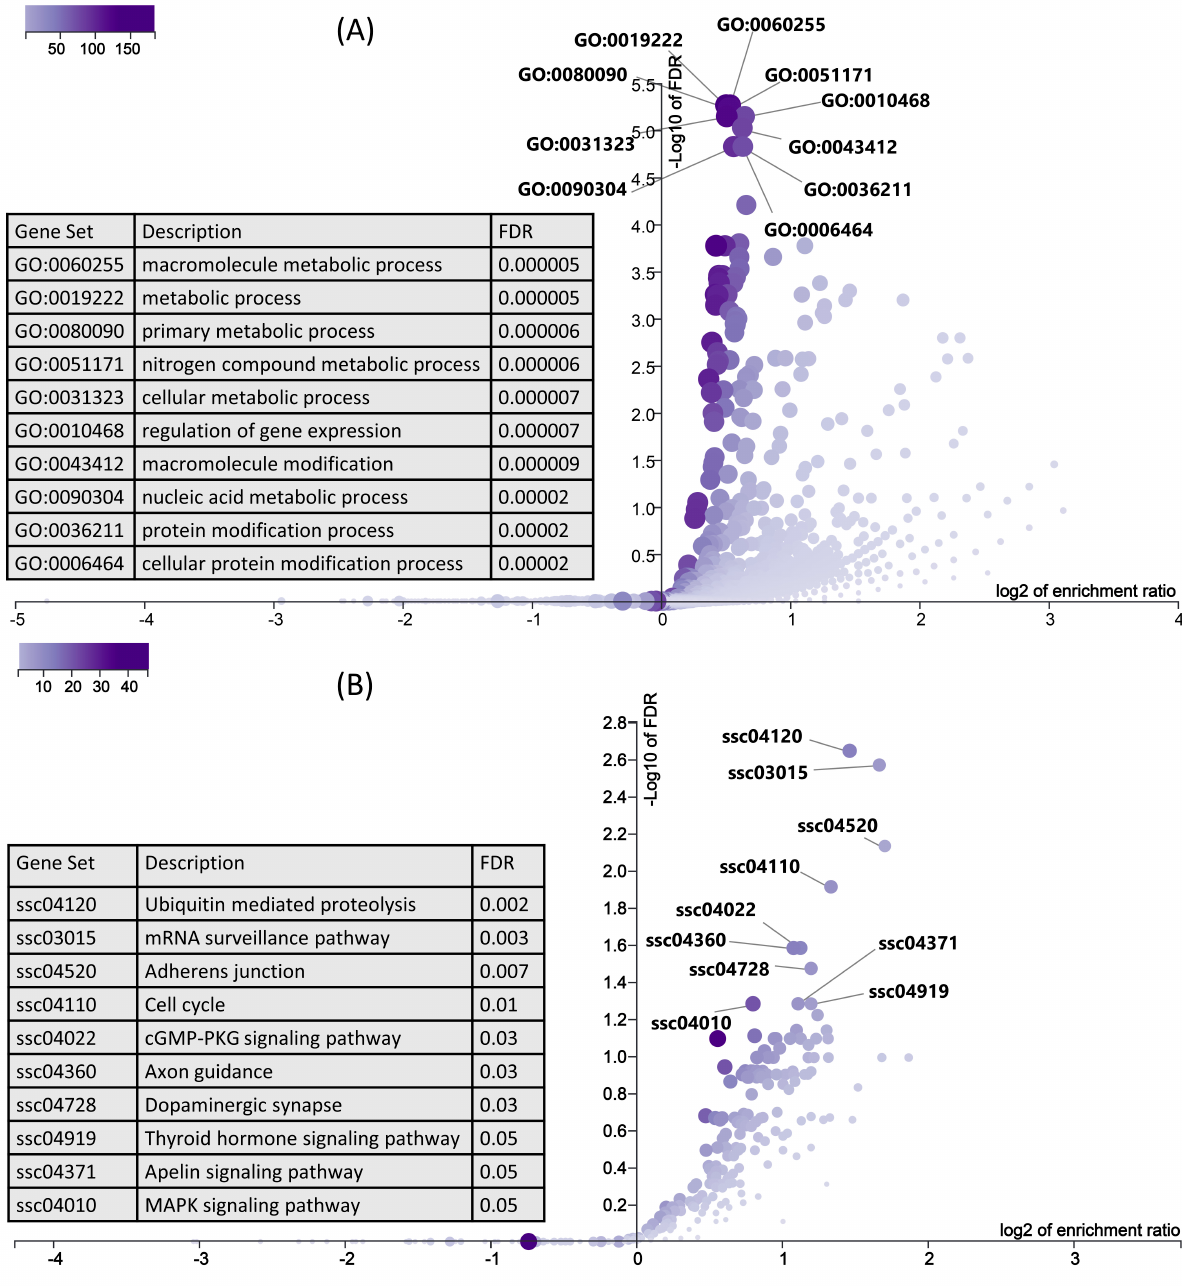
Figure 7. ORA results for upregulated genes, which are negatively correlated and targeted by downregulated miRNAs. ( A ) Biological processes significantly enriched by upregulated genes in LDM from IUGR fetuses at 63 dpc, derived using WebGestalt. A complete list of biological processes enriched by downregulated genes is provided in Table S4. ( B ) KEGG pathways enriched by upregulated genes in LDM from IUGR fetuses at 63 dpc, derived using WebGestalt.